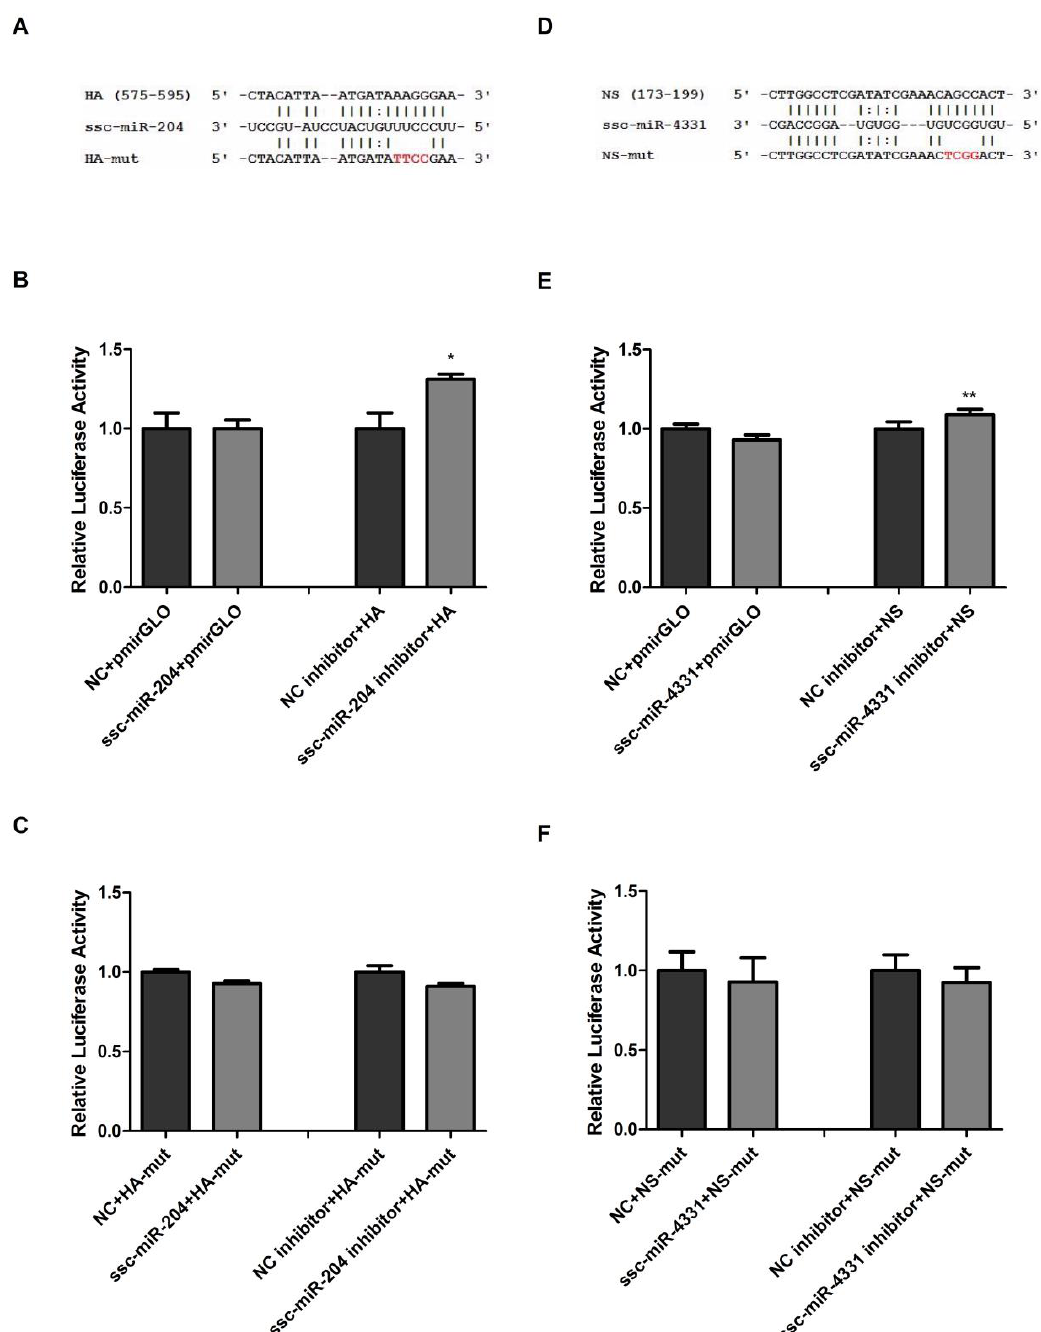
Figure 2. Ssc-miR-204 and ssc-miR-4331 targeted viral HA and NS of SIV-H1N1/2009, respectively. Sequence alignments of ssc-miR-204 and its target sites in viral HA ( A ); and that of ssc-miR-4331 and its target sites in viral NS ( D ). Four mutated nucleotides of the target sites were indicated in red. NPTr cells were firstly cotransfected with the luciferase reporter vector pmirGLO ( B , E ) or wild-type reporter pmirGLO-HA ( B , E ) or the mutated reporter pmirGLO-HA-mut ( C , F ) with the indicated RNA oligonucleotides, then the cell lysates were harvested for dual-luciferase reporter assays 24 h post-transfection. Data were shown as relative firefly luciferase activities normalized to the value of renilla luciferase. Significant levels were analyzed by Student’s t -test, * p ≤ 0.05, ** p ≤ 0.01. 2.3. Ssc-miR-204 and ssc-miR-4331 Repressed the Expression of Viral HA1 and NS1 Respectively, and Inhibited the Replication of SIV-H1N1/2009